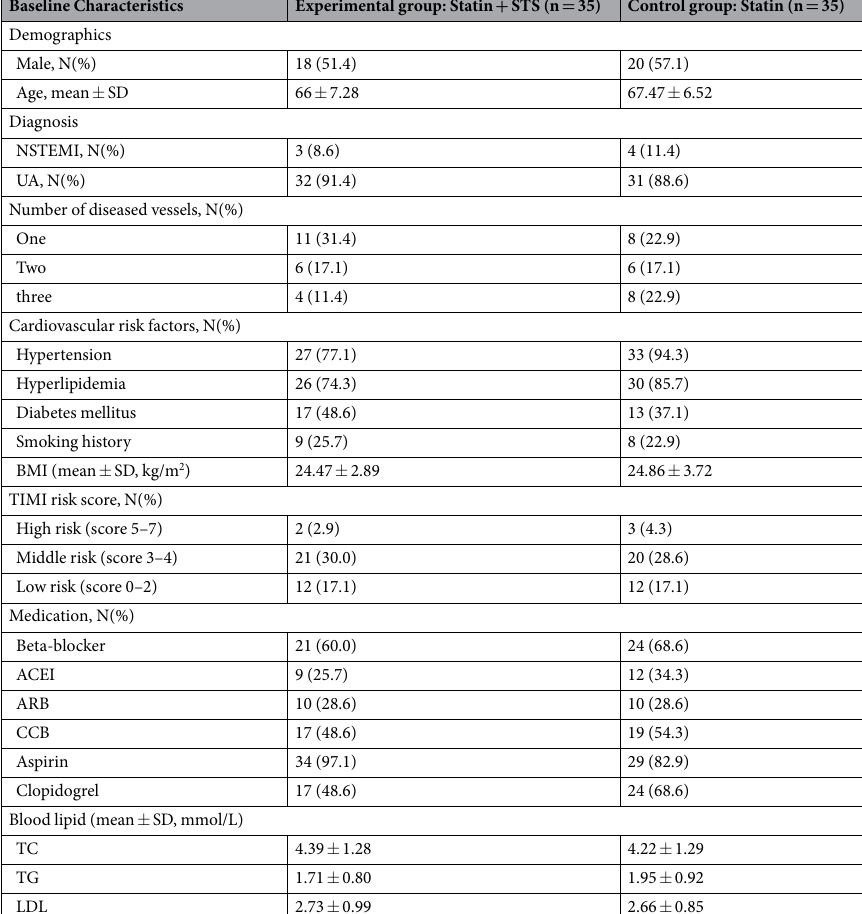
Table 1. Baseline Characteristics. All comparisons between the groups were not significantly different (p > 0.05 for all). ACEI, angiotensin-converting enzyme inhibitor; ARB, angiotensin receptor blocker; BMI, body mass index; CCB, calcium channel blocker; IQR, interquartile range; LDL, low density lipoprotein; NSTEMI, non-ST segment elevation myocardial infarction; SD, standard deviation; TC, total cholesterol; TG, triglyceride; TIMI, Thrombolysis in Myocardial Infarction; UA, unstable